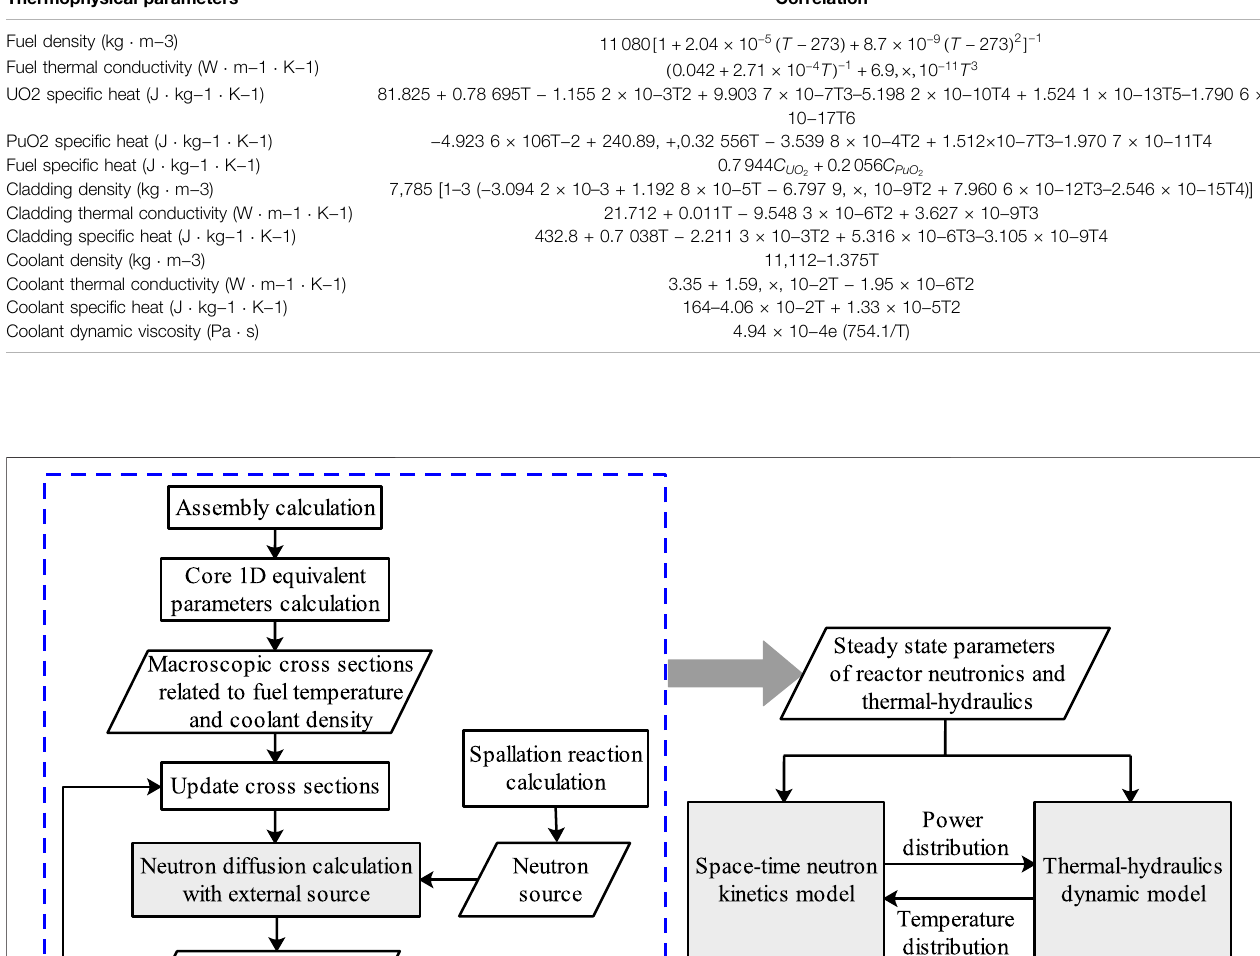
TABLE 1 | Thermophysical properties of fuel, cladding and coolant. Thermophysical parameters